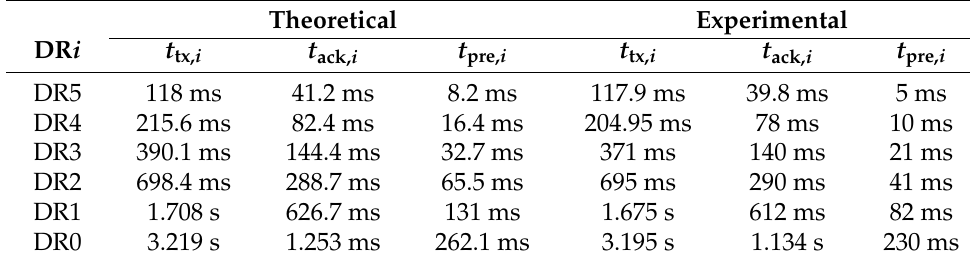
Table 6. Data and ACK frame